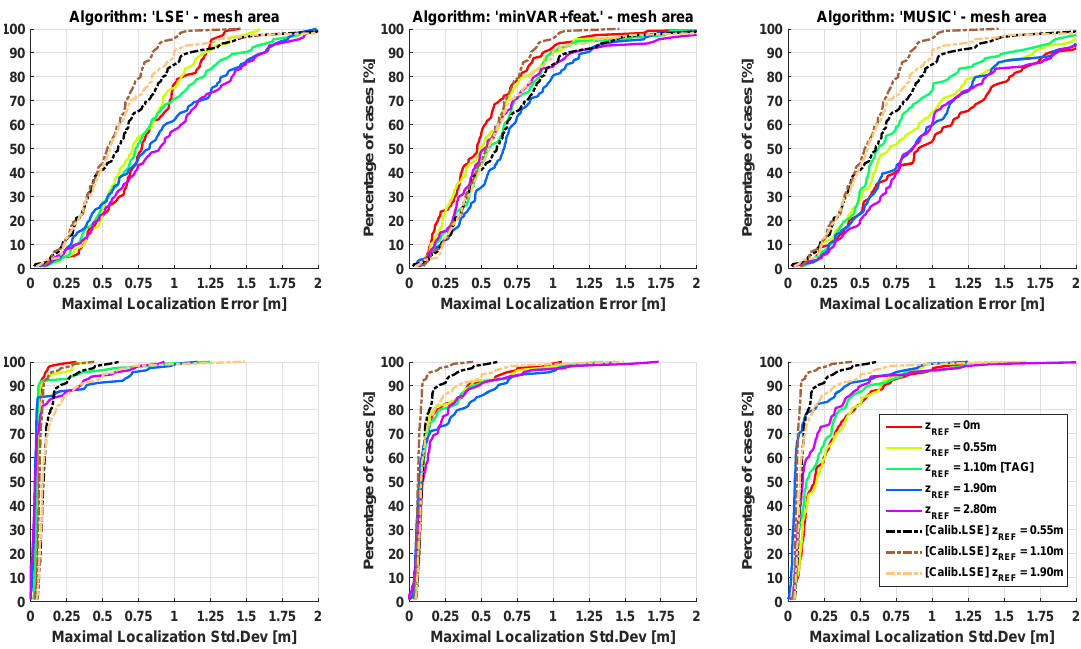
Algorithm: 'minVAR+feat.' - mesh area